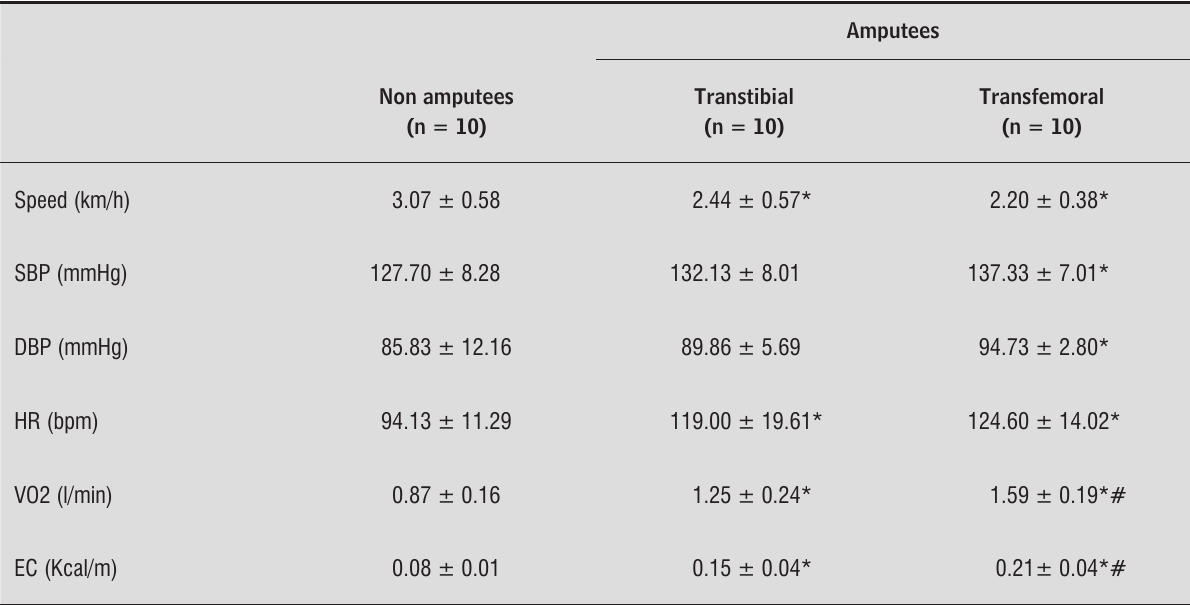
Table 2 - Mean and standard deviation of speed, systolic blood pressure (SBP), diastolic blood pressure (DBP), heart rate (HR), oxygen consumption (VO ) and energy cost (EC) for the three walking speeds analyzed and compared 2 between groups Amputees Non amputees Transtibial Transfemoral (n = 10) (n = 10) 3.07 ± 0.58 2.44 ± 0.57*